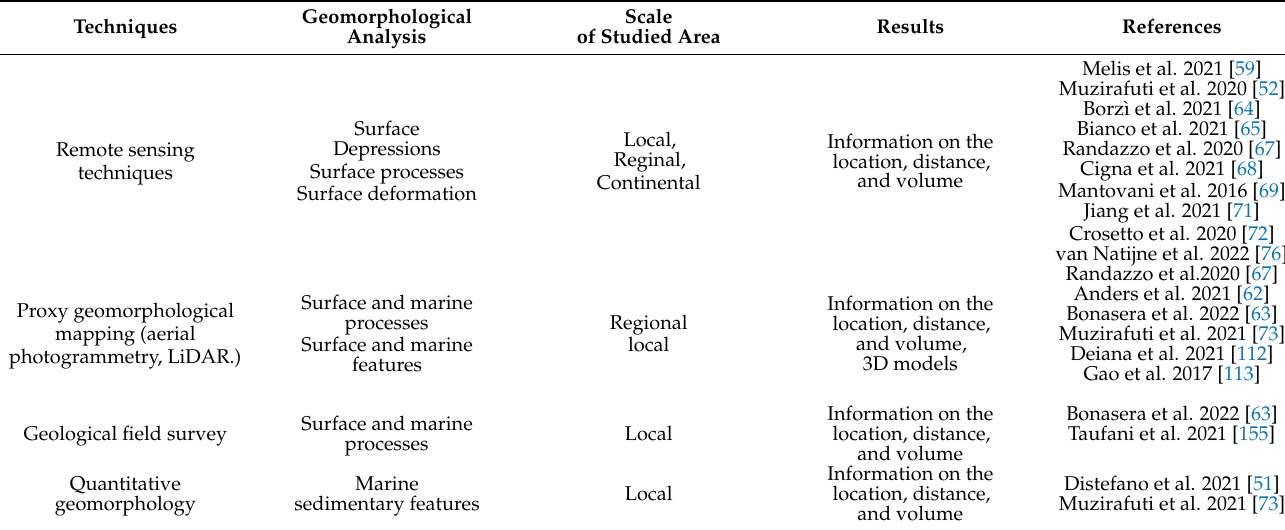
Table 3. Surface geomorphology technical